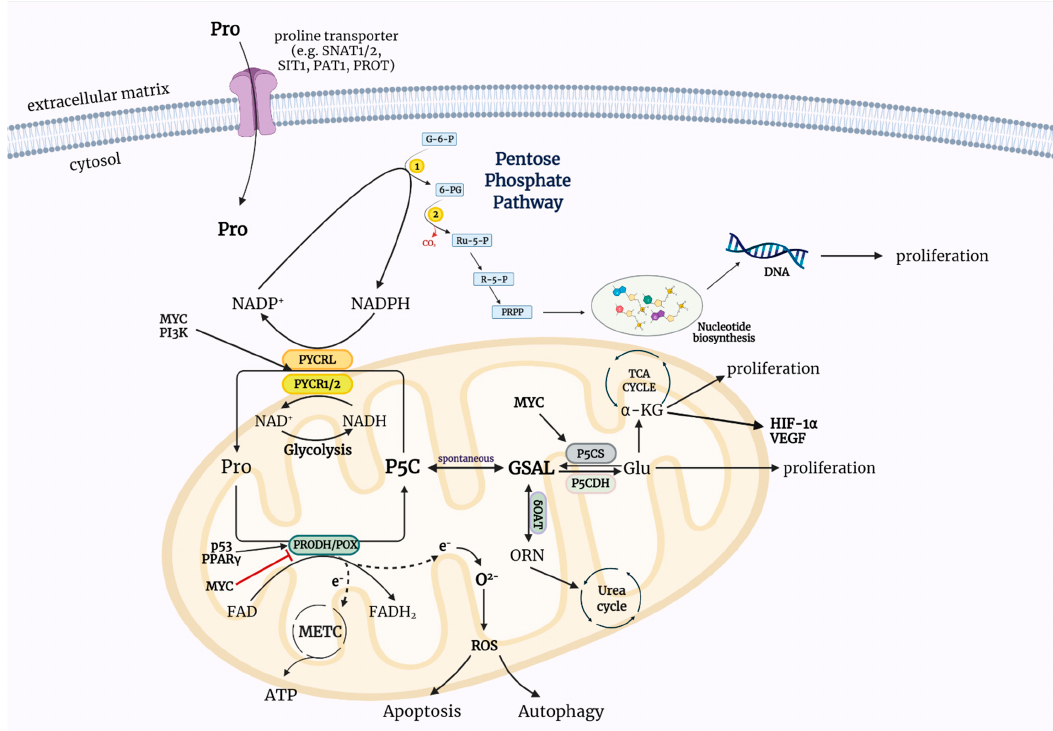
Figure 2. The importance of the P5C-proline cycle in cancer metabolism. Metabolism of P5C depended on specific enzymes establish to the P5C-proline cycle. The activity of these enzymes is accompanied by transport of redox equivalents between the mitochondria and the cytosol that determine cellular processes—proliferation, survival, apoptosis, autophagy. The interconversion of P5C and proline changes the NADP + /NADPH ratio in the cell leading to regulation of phosphoribosyl pyrophosphate (PRPP) synthesis and nucleotide synthesis via pentose phosphate pathway. ATP—adenosine triphosphate, FAD—oxidized form of flavin adenine dinucleotide, FADH 2 —reduced form of flavin adenine dinucleotide,